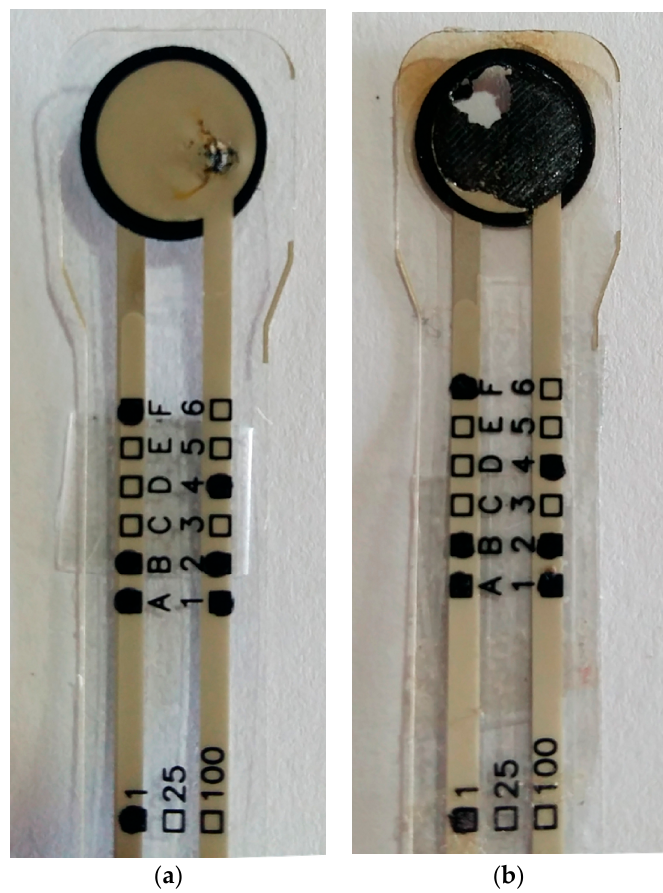
Figure 18. Pictures of burned-out FlexiForce sensors when loaded with ( a ) σ = 46 KPa at 58 V and with ( b ) σ = 1.8 MPa at 50 V. A FSR is equal to 41.85 mm 2 in both cases.